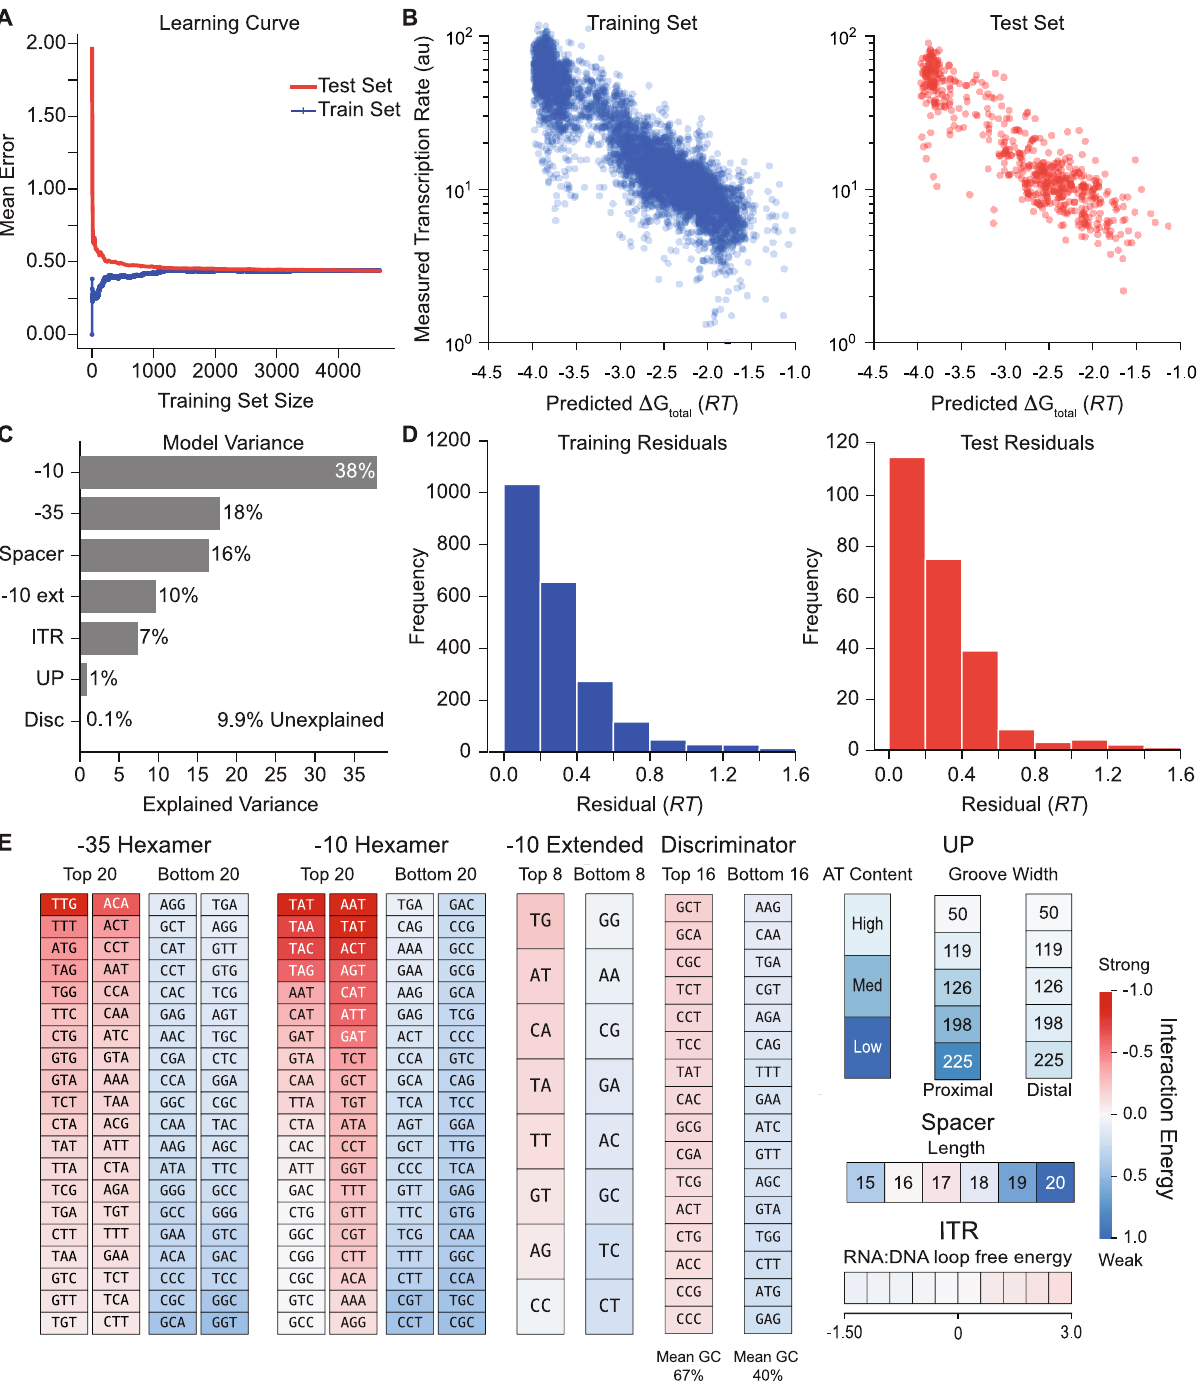
shown. D Histograms of modelerrorareshownforthetraining and testsets, using energyunits.Meanabsoluteerror(MAE)isequalto0.27 RT forthetrainingset(left) and0.28 RT forthetestset(right). E Thelearnedinteractionenergiesareshownfor the strongest and weakest ones. A poster-sized schematic showing all interaction energies is available (Supplementary Information). Data are provided in Supple- mentary Data